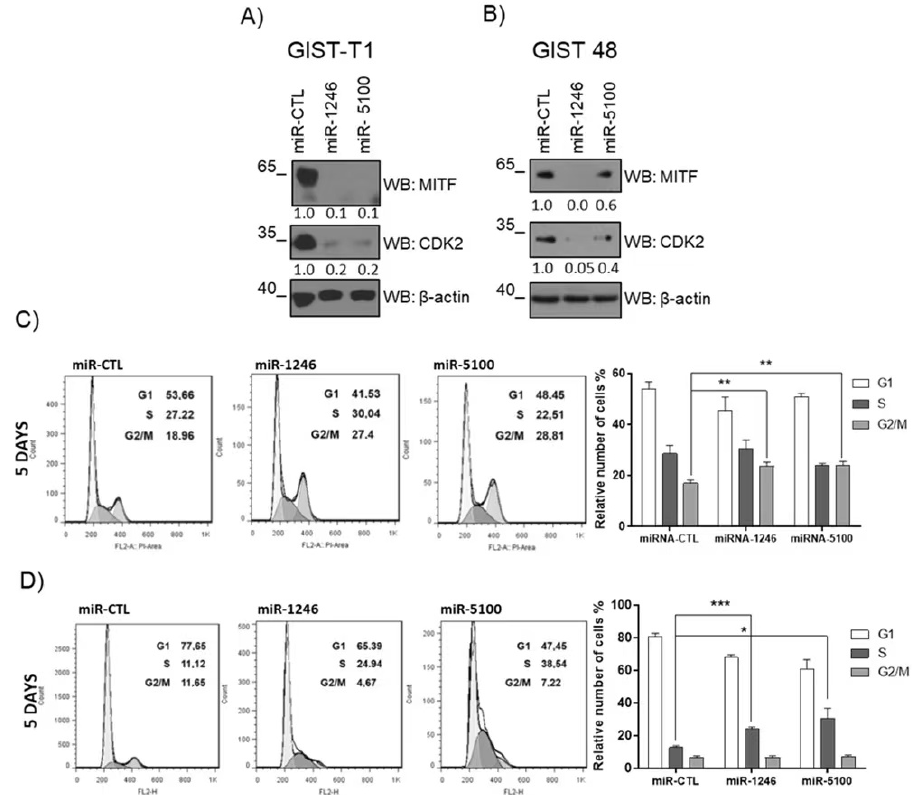
Figure 1. new Figure 4. Figure 6. MiR-1246 and miR-5100 arrest cell cycle in GISTs cells. Western blots were performed on GIST cells on the 5th days after lentiviral miRNAs transduction; lysates were analyzed to determine MITF and CDK2 levels in ( A ) GIST-T1 and ( B ) GIST 48. Cell cycle assay was performed by FACS, and miRNA–CTL was used as a control. Results were analyzed by Dean/Jett/Fox model Flow jo 7.0 software ( C ) GIST-T1 n = 4, ( D ) GIST 48 n = 3 (* p < 0.05, ** p < 0.01, *** p < 0.001; Unpaired t -test; mean ±